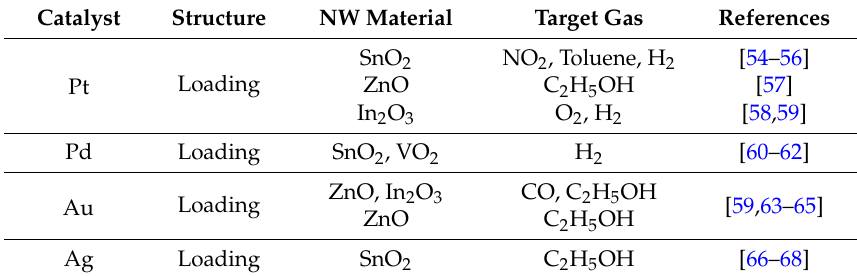
Table 1. Gas sensors using noble-metal-catalysts-loaded nanowires (NWs) in the literature [54–68].